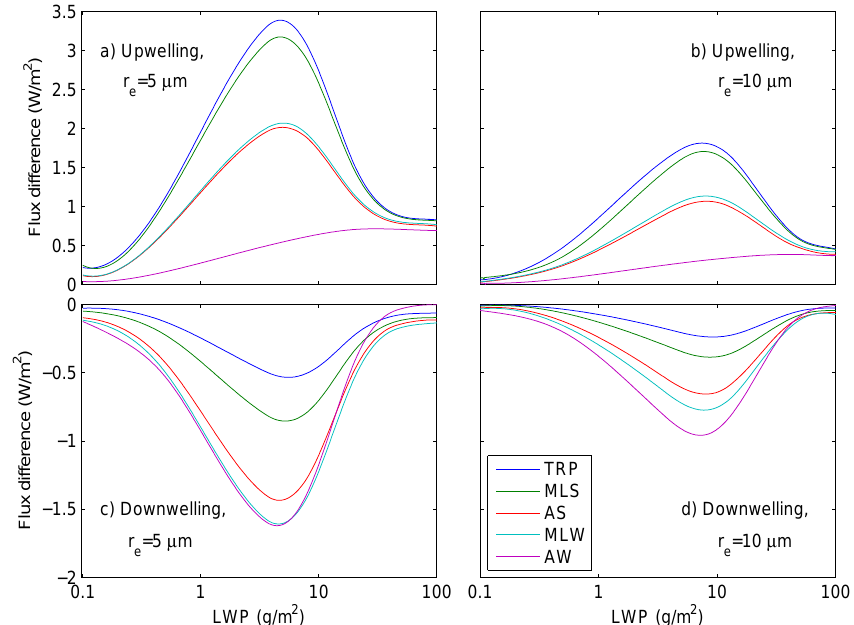
Fig. 4. Difference between flux simulated using the 300K complex retractive index (CRI) and using a 240K CRI (see text for explanation) as a function of cloud liquid water path (LWP) for single-layer liquid clouds with effective radii of 5 and 10 µm in a variety of model atmospheres (Arctic winter: AW, midlatitude winter: MLW, Arctic summer: AS, midlatitude summer: MLS, and tropical: TRP), for upwelling flux at the top of atmosphere ( a and b ) and downwelling flux at the surface ( c and d